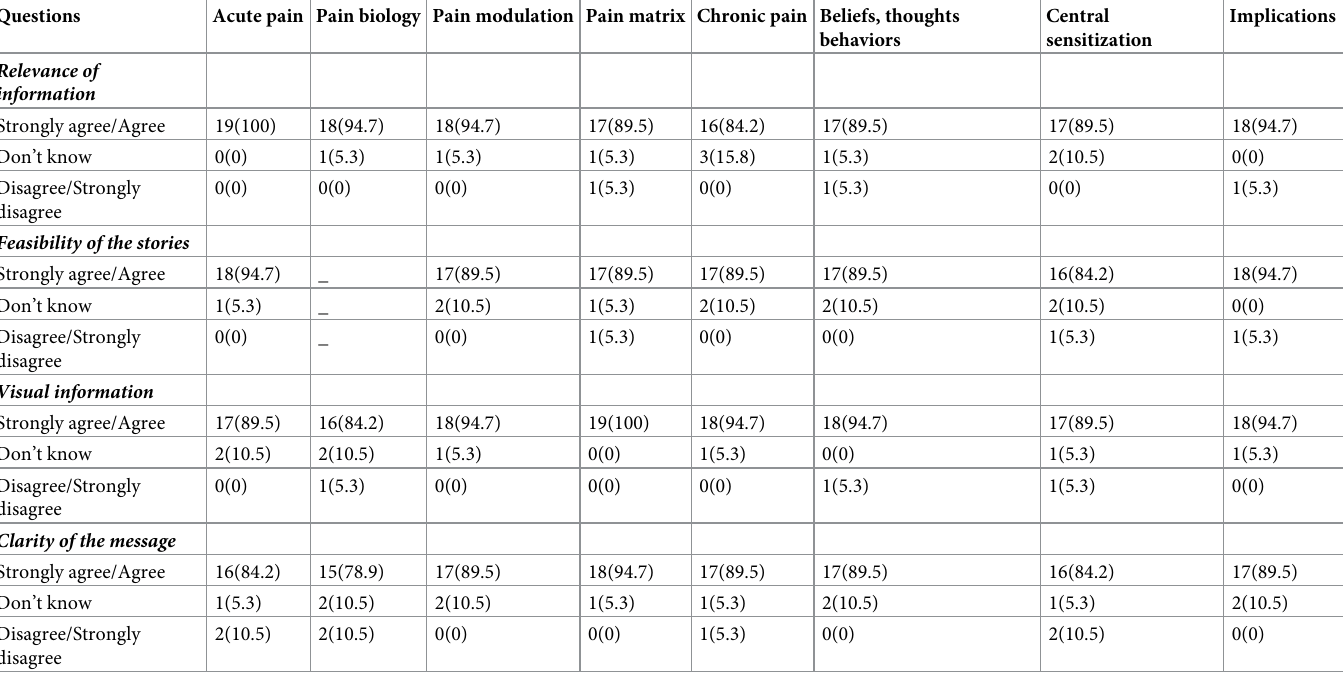
Table 2. Results of the Delphi round 1 (teaching materials for males and females) (n =